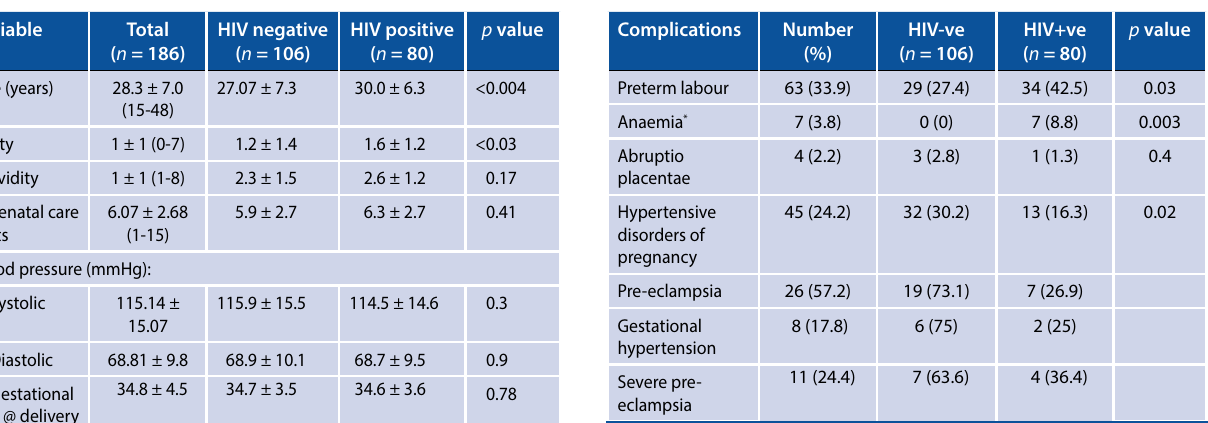
Table 2: Obstetric complications in HIV uninfected and HIV infected women with twin deliveries